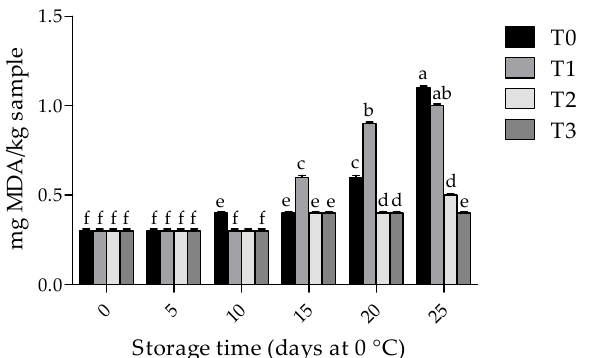
Figure 2. E ff ect of chitosan with GTWE and storage time on lipid oxidation of meat samples. Values expressed as mean ± standard deviation. T0 (non-coated chops and without antioxidant); T1 (chitosan-coated chops without antioxidant); T2 (chitosan-coated chops with 0.1% of GTWE); and T3 (chitosan-coated chops with 0.5% of GTWE). Di ff erent superscripts (a–f) indicate significant di ff erences among treatment × storage time e ff ect ( p < 0.05).